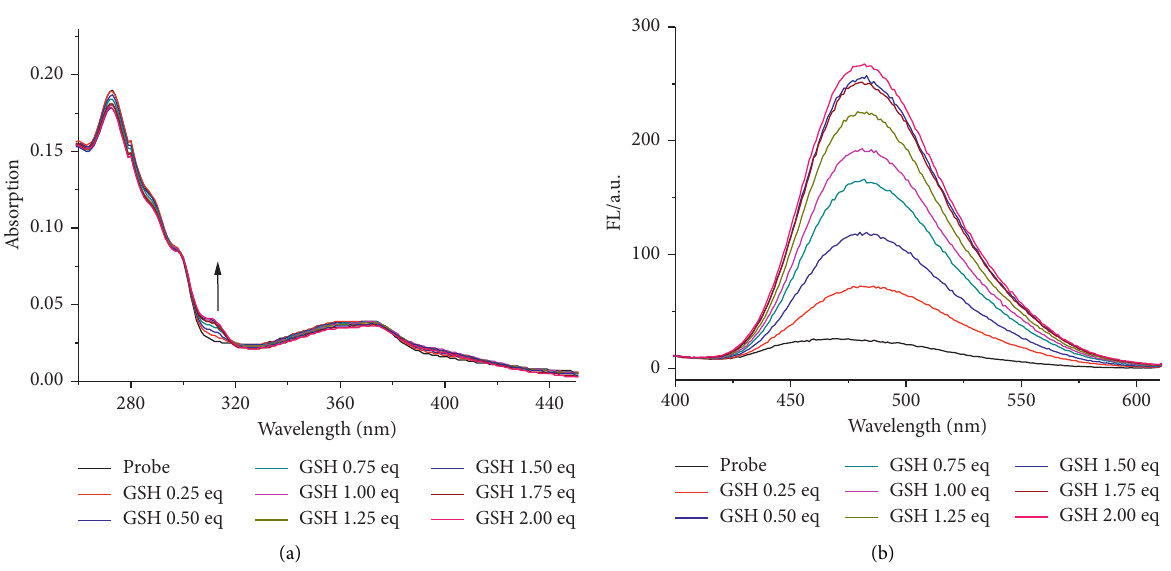
Figure 2: (a) The absorption spectral changes of KL-DN (10 μ M) upon addition of 2 eq GSH. (b) The fluorescence spectral changes of KL- DN (10 μ M) upon addition of GSH, λ ex � 310nm. All the solutions are in DMSO/PBS buffer (1:1, v/v, pH 7.4).